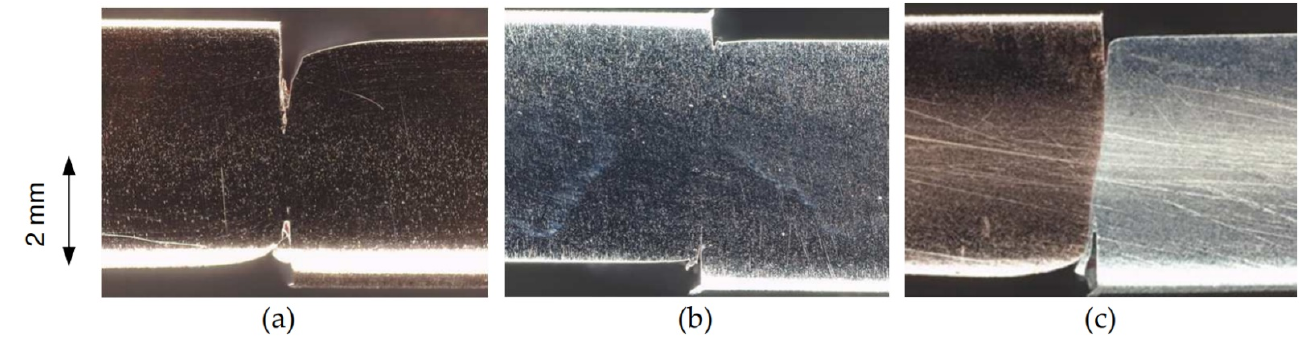
Figure 5. Cross-section of joint boundary using sheared surface: ( a ) C1100-C1100, Contact length: 1.7 mm; ( b ) A6061-A6061, 3.3 mm; ( c ) C1100-A6061, 2.5 mm.